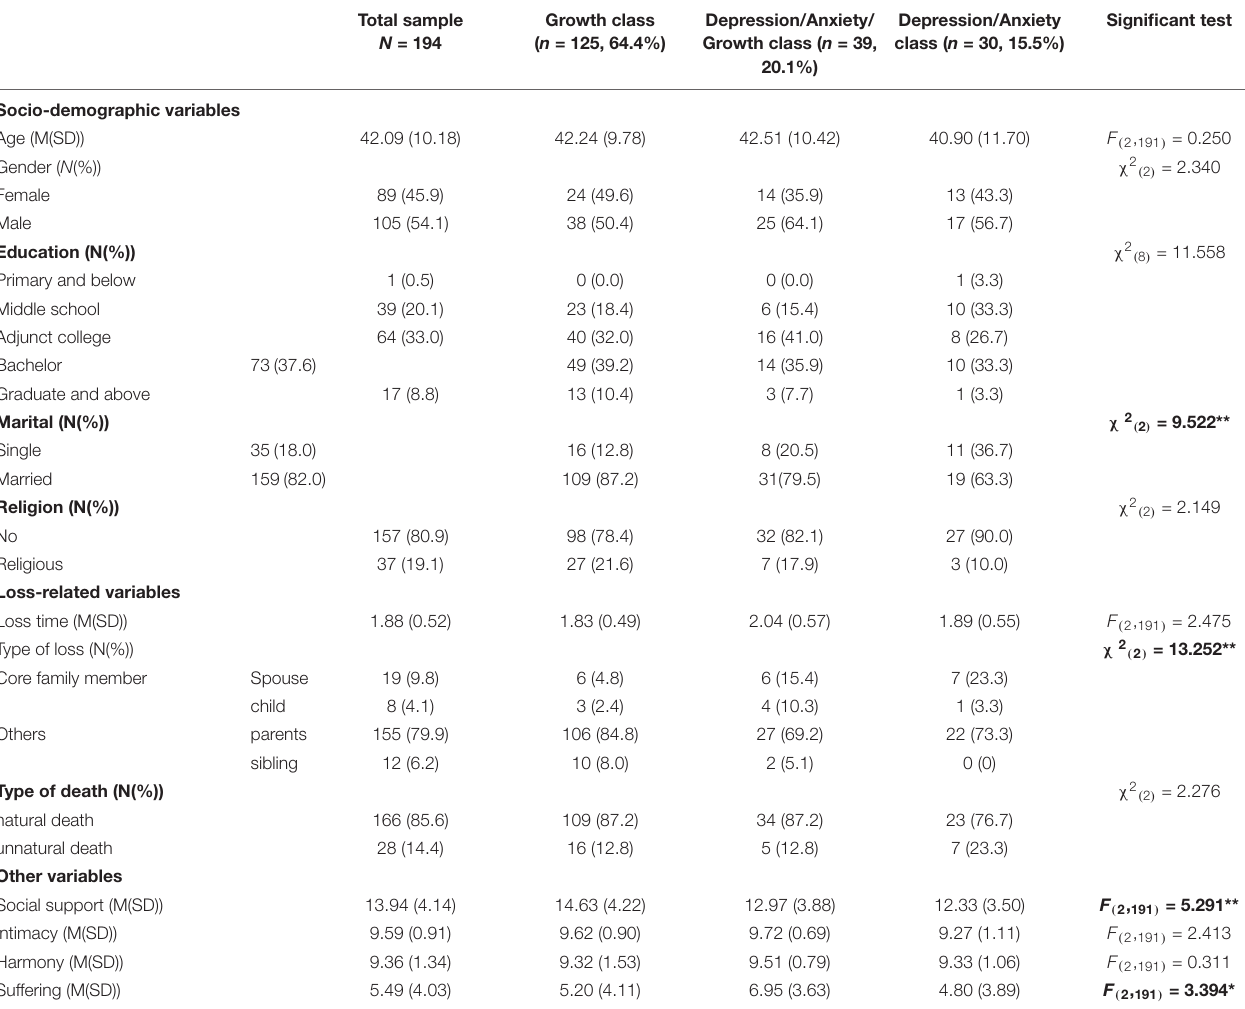
TABLE 1 | Socio-demographic, loss-related and other characteristics.